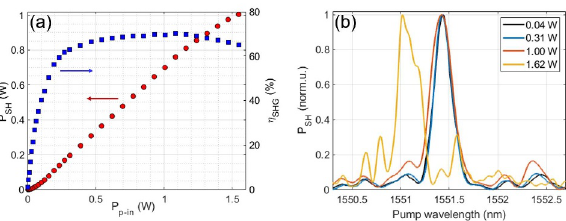
Fig. 4. (a) P SH (circles) and η SHG (squares) versus P p-in . (b) SHG tuning curves for different coupled pump powers P p-in .